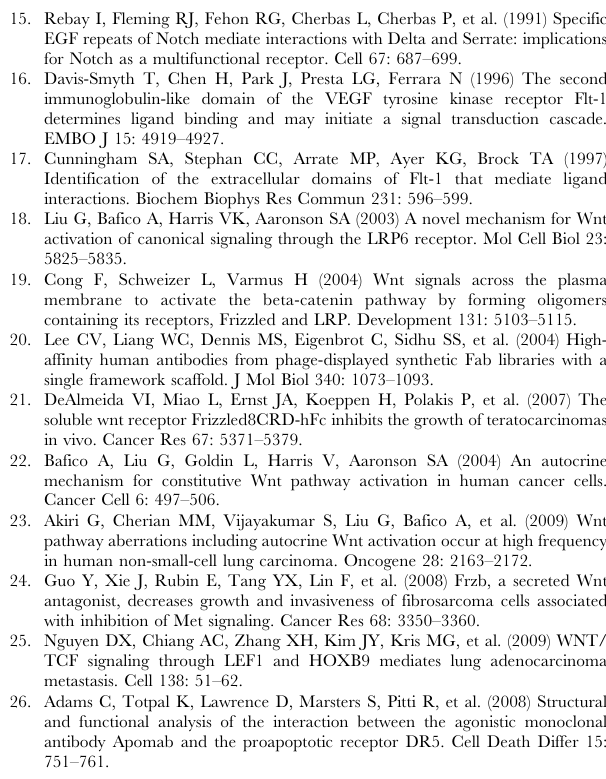
competing soluble LRP6 protein was normalized to 100%. Figure S2 RNAi of candidate autocrine Wnts identifies isoforms mediating endogenous signaling in tumor cell lines. (A–D) Individual and pools of four siRNAs against Wnt isoforms were transfected into PA-1 (A), M14 (B), Hs578T (C), and NCI-H23 (D) cell lines stably integrated with Wnt luciferase reporter. Expression of luciferase is normalized to cell number and additionally normalized to levels in cells not transfected with siRNA. b - catenin, LRP6, and LRP5 RNAi, as well as Fzd8CRD-Fc protein